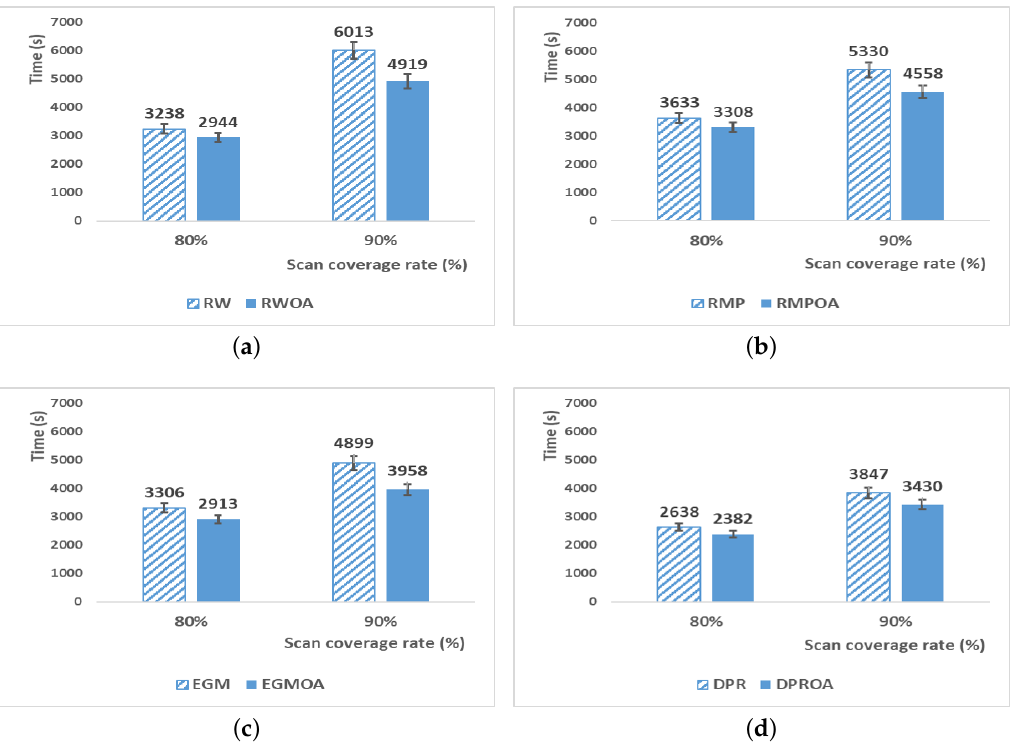
Figure 8. The 80%- and 90%-coverage reaching times with/without Overlap Avoidance: ( a ) Random Waypoint; ( b ) Random Markov Process; ( c ) Enhanced Gauss–Markov; and ( d ) Distributed Pheromone